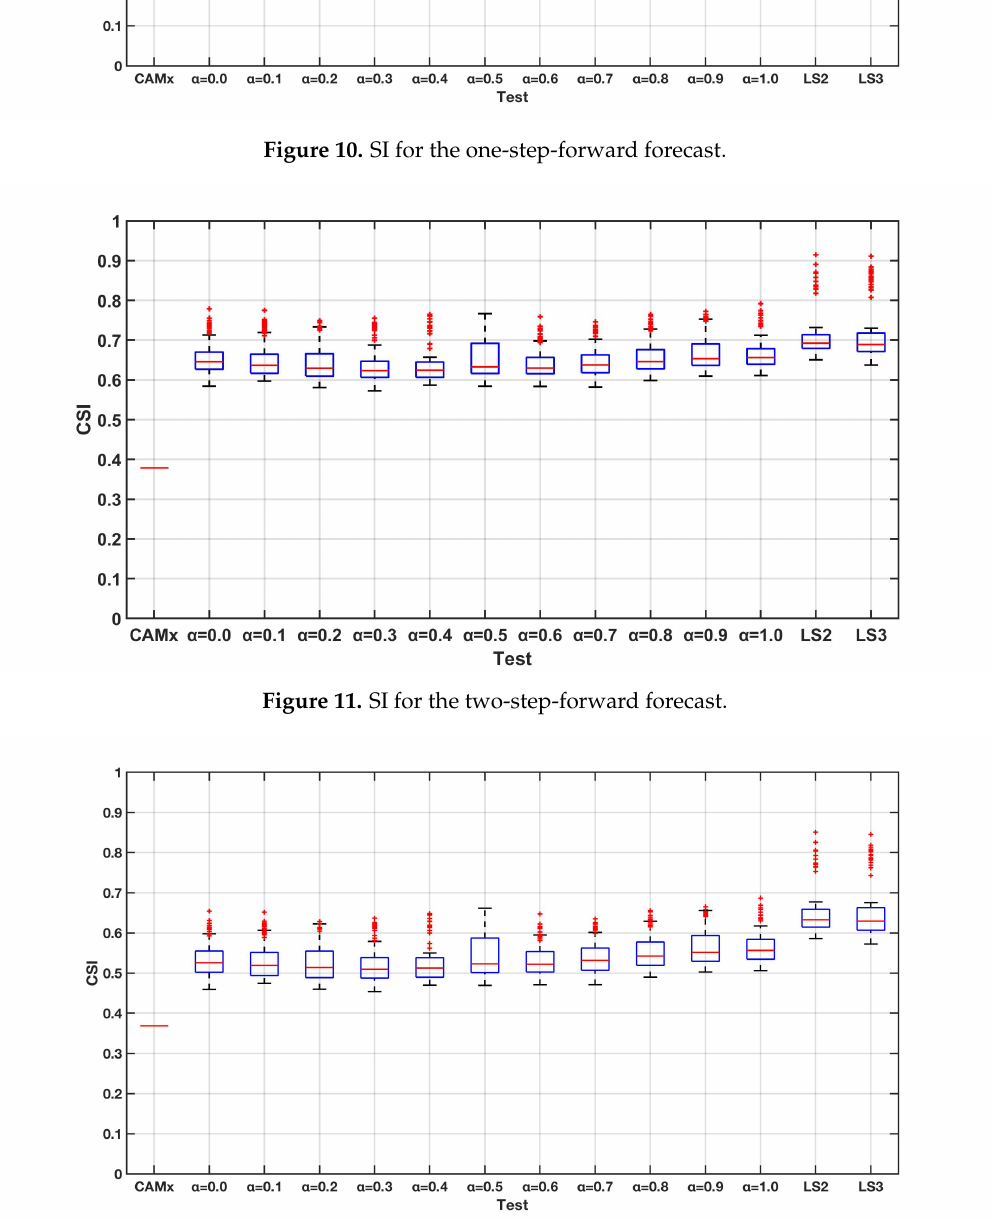
Figure 12. SI for the three-step-forward